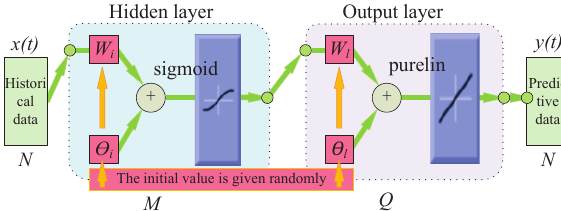
Figure 3. BP neural network structure.